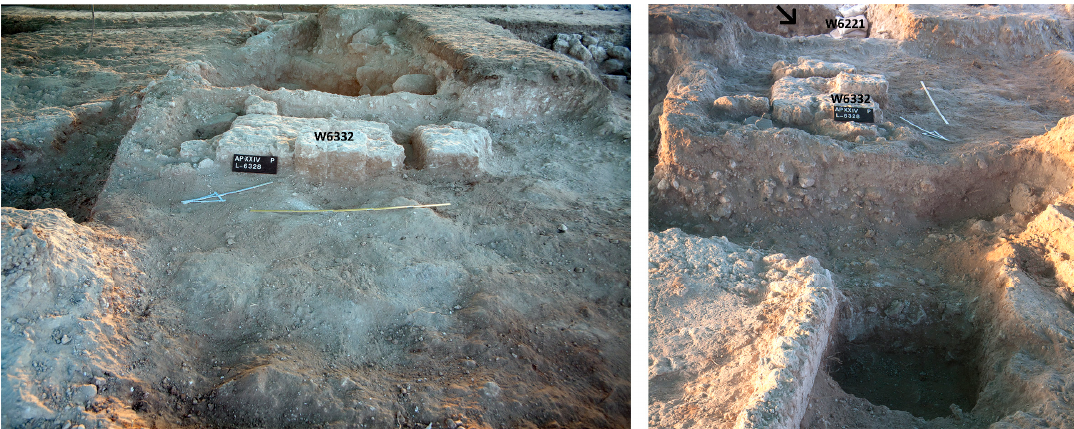
Figure 7. Apollonia-Arsuf, Area P1. (1) Wall 6332, looking east. (2) Wall 6221 (top), Wall 6332 (center), with an arrow marking the assumed corner, looking south (Pavel Shrago).